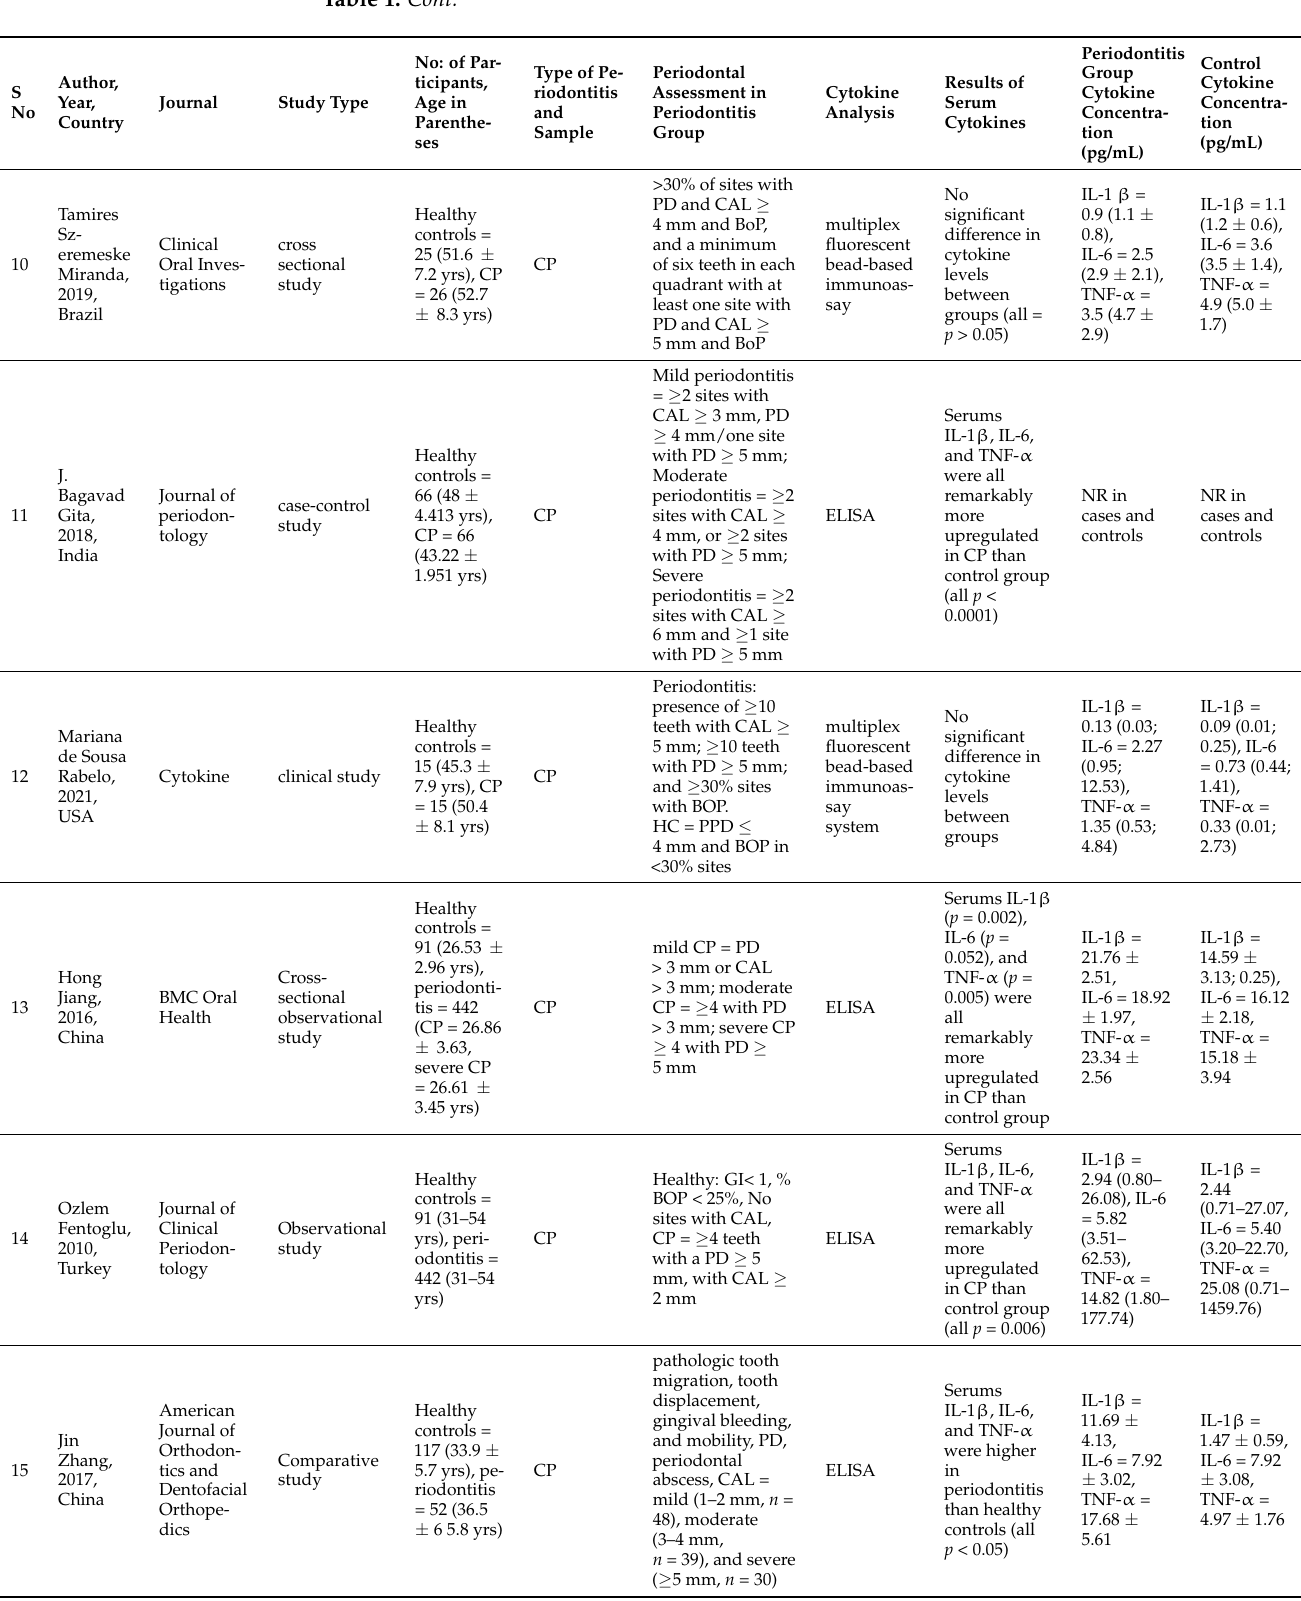
Table legends: CP = chronic periodontitis; AgP = Aggressive periodontitis; PD = pocket depth; CAL= clinical attachment loss; BI = bleeding index; PI = plaque index; GI = gingival index; BOP= bleeding on probing; GCP = generalized chronic periodontitis; GCF = gingival crevicular